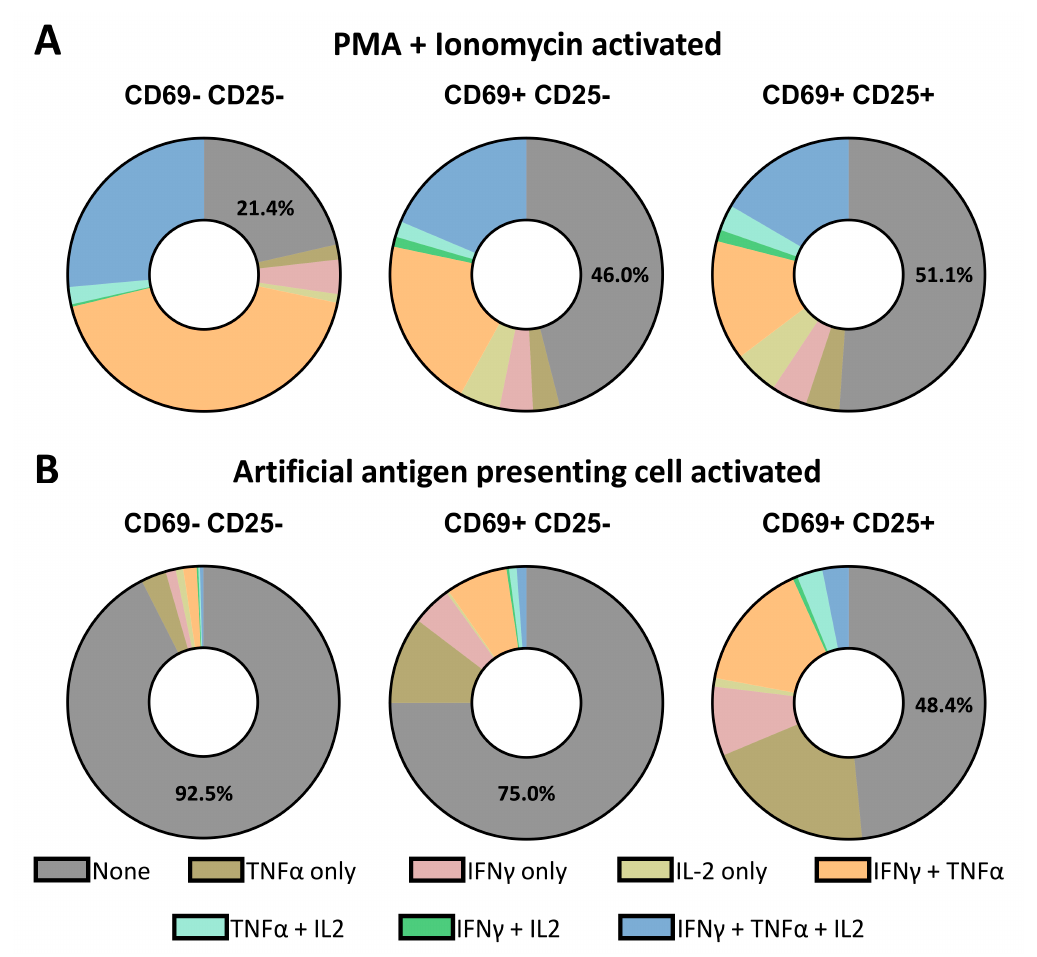
Figure 5. Comparing heterogeneous cell responses between PMA/Ionomycin and aAPC activation. ( A ) Pie graphs displaying the different profiles of secretion after PMA/Ionomycin stimulation of CTLs, n = 3 donors. ( B ) Pie graphs displaying the different profiles of secretion after aAPC stimulation of CTLs, n = 5 donors.